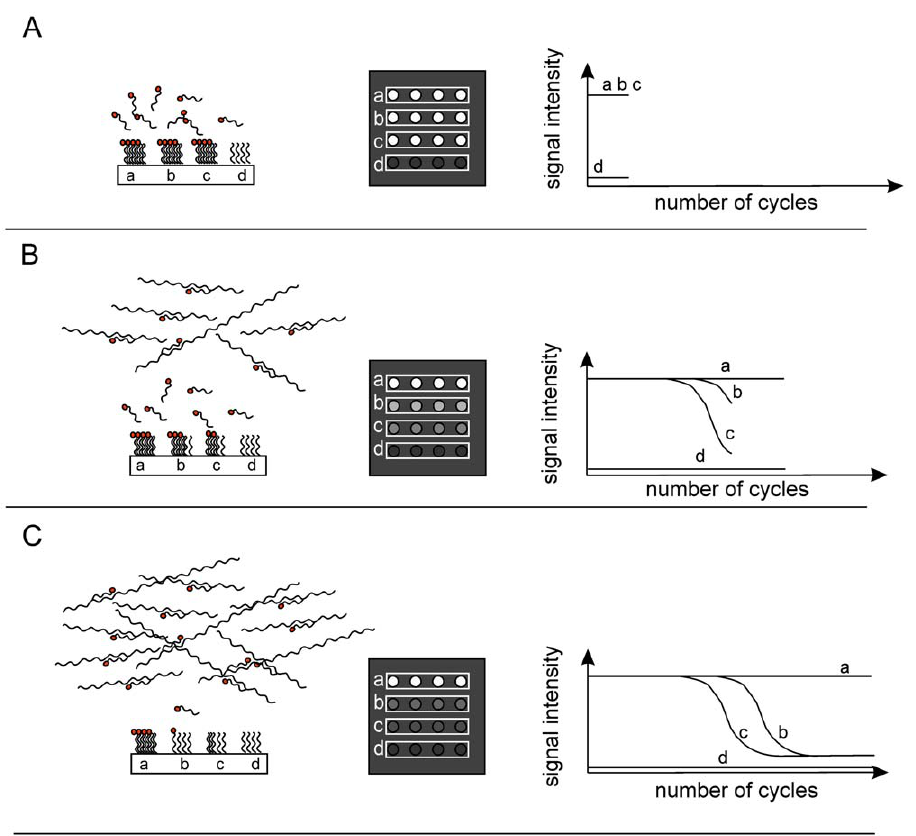
Figure 6. General principle of the competitive reporter monitored amplification (CMA) method. At the onset of the amplification reaction, only a few targets are present. Reporter probes are free to bind to the complementary capture probe on the array (panel A) . Hybridization kinetics are driven by the concentration of reporter probes in solution, the amount of the respective surface immobilized capture probes and reaction conditions like temperature and salt concentration. As the amplification reaction proceeds (panel B) , more and more target amplicons with a reporter probe specific binding site are synthesized. Along with the accumulation of the target amplicons, the hybridization kinetic becomes dominated by the concentration of target amplicons. As more target amplicons are synthesized, more reporter probes bind to target amplicons. Therefore, the amount of reporter probes hybridized to the complementary capture probes decreases proportionally to the formation of new target amplicons. A decrease in fluorescence signal intensity is observed on the respective position on the capture probe array, until the amplification reaction reaches a plateau (panel C) . The change in signal intensity is determined by analysis of the sequential fluorescence patterns on the capture probe